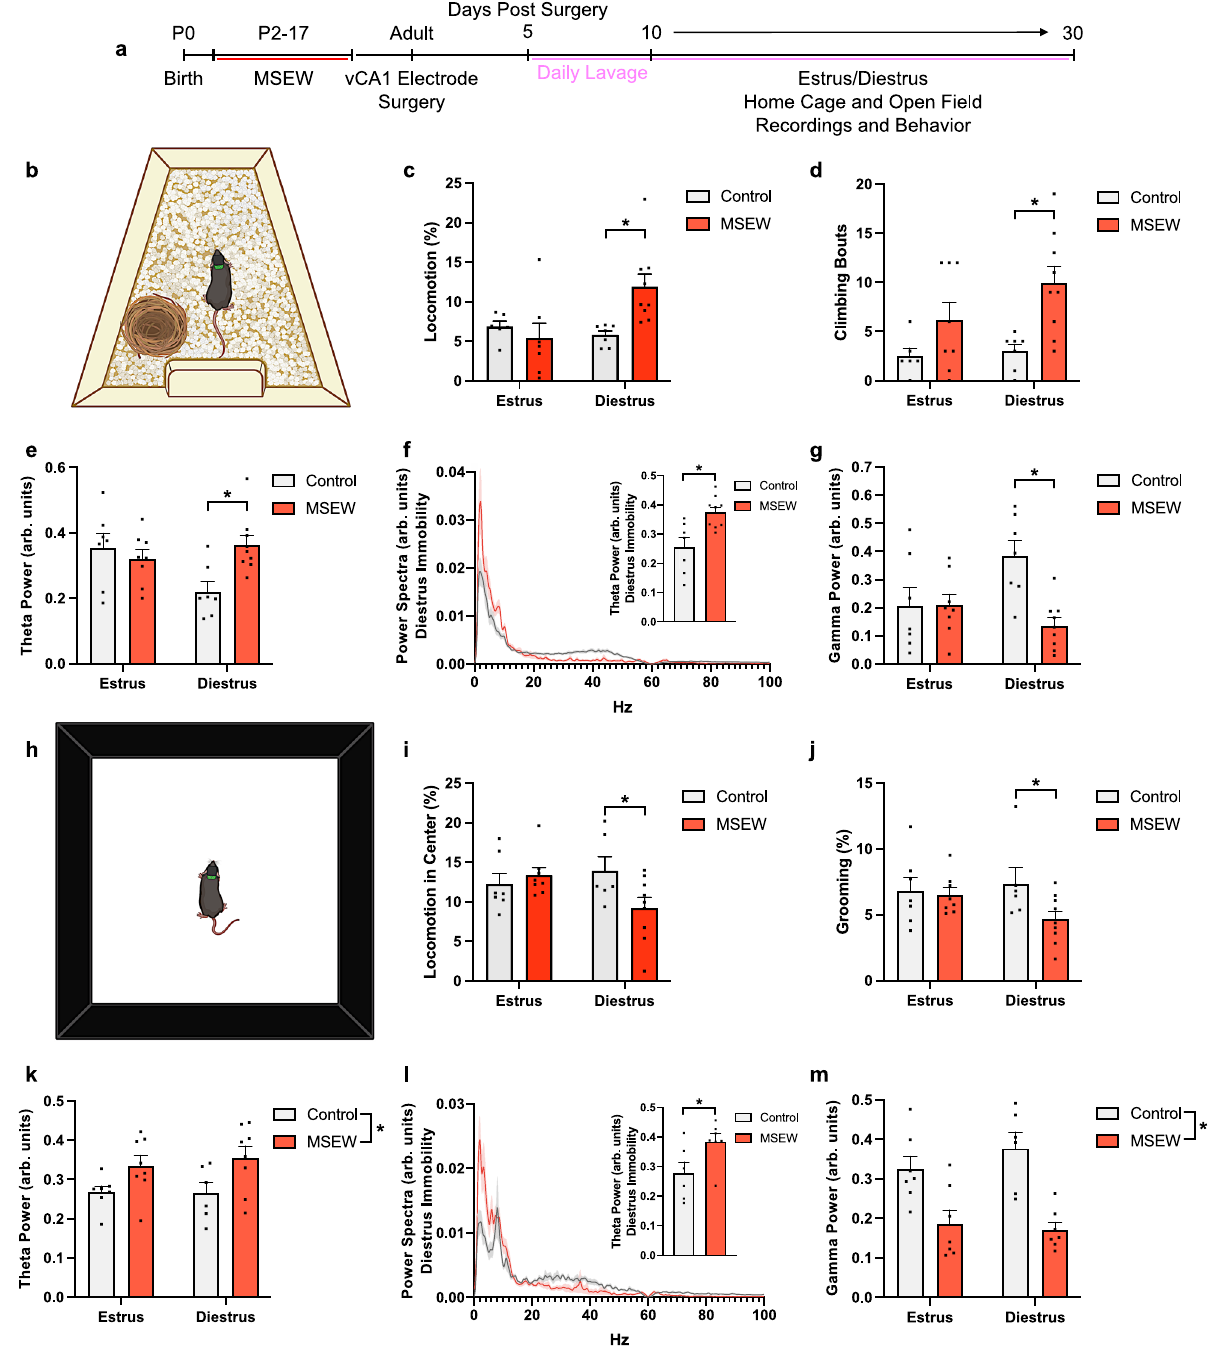
Fig.2|MSEWaltersactivitylevelsandvHIPthetaoscillationsdependingonthe context. a Timeline of experiment. b Schematic of recording in home cage. c Locomotion in the home cage is increased in MSEW mice in diestrus ( F 1,8 =7.132, p =0.0283; Control-MSEW Diestrus p =0.0226; Control n =9, MSEW n =10). d Climbing in the home cage is increased in MSEW mice in diestrus ( F 1,10 =5.112, p =0.0473; Control-MSEW Diestrus p =0.0027; Control n =8,MSEW n =10). e vHIP thetapowerisincreasedinMSEWmiceindiestrus( F 1,10 =7.238, p =0.0238;Control- MSEW Diestrus p =0.0090; Control n =9, MSEW n =10). f Power spectra from diestrus vHIP LFPs during home cage immobility in control and MSEW mice, inset graph shows vHIP theta power is higher in diestrus MSEW mice during